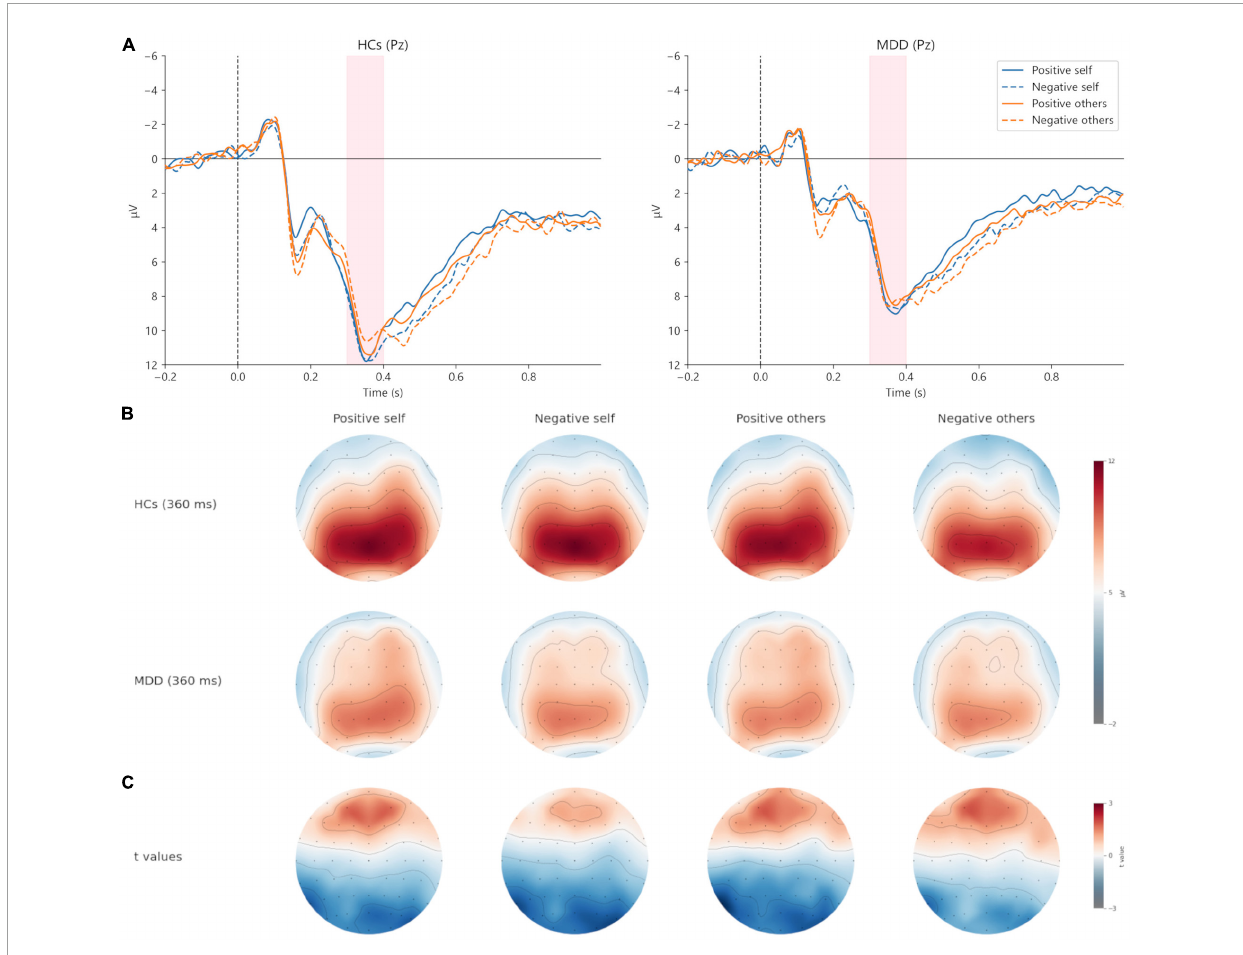
FIGURE5 Grand averages (A) of P300 (300–400 ms) at Pz electrodes under positive self (blue solid lines), negative self (blue dashed lines), positive others (orange solid lines), and negative others (orange dashed lines) condition. Topographic maps of P300 at 360 ms (B) under four conditions. Topographic distribution of t values for P300 between MDD and HCs (C) under four conditions. MDD, major depressive disorder; HCs, healthy controls.